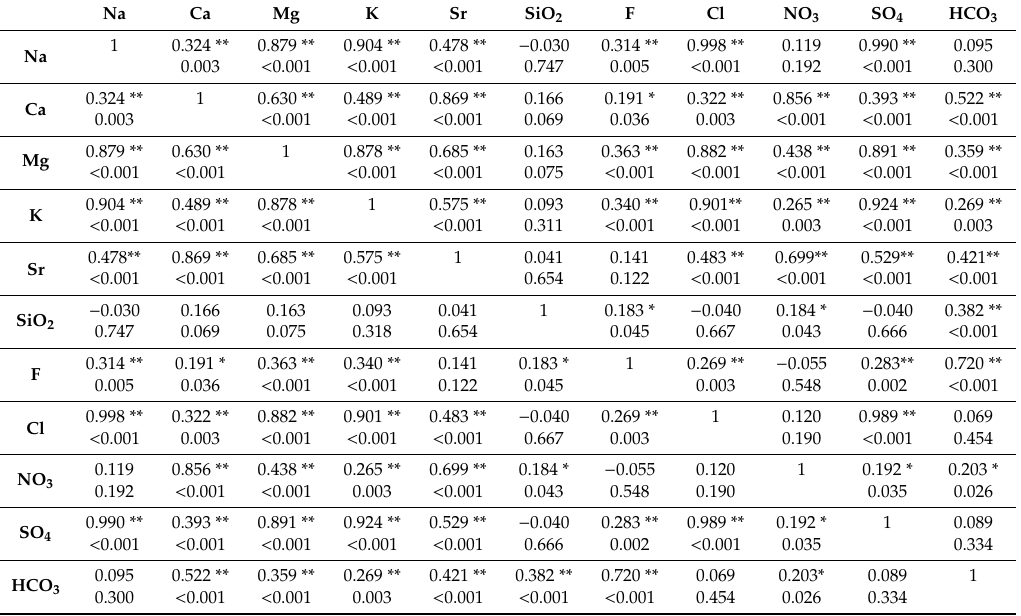
Table 3. The matrix of correlation coe ffi cients among chemical components of groundwater and spring water in Jeju